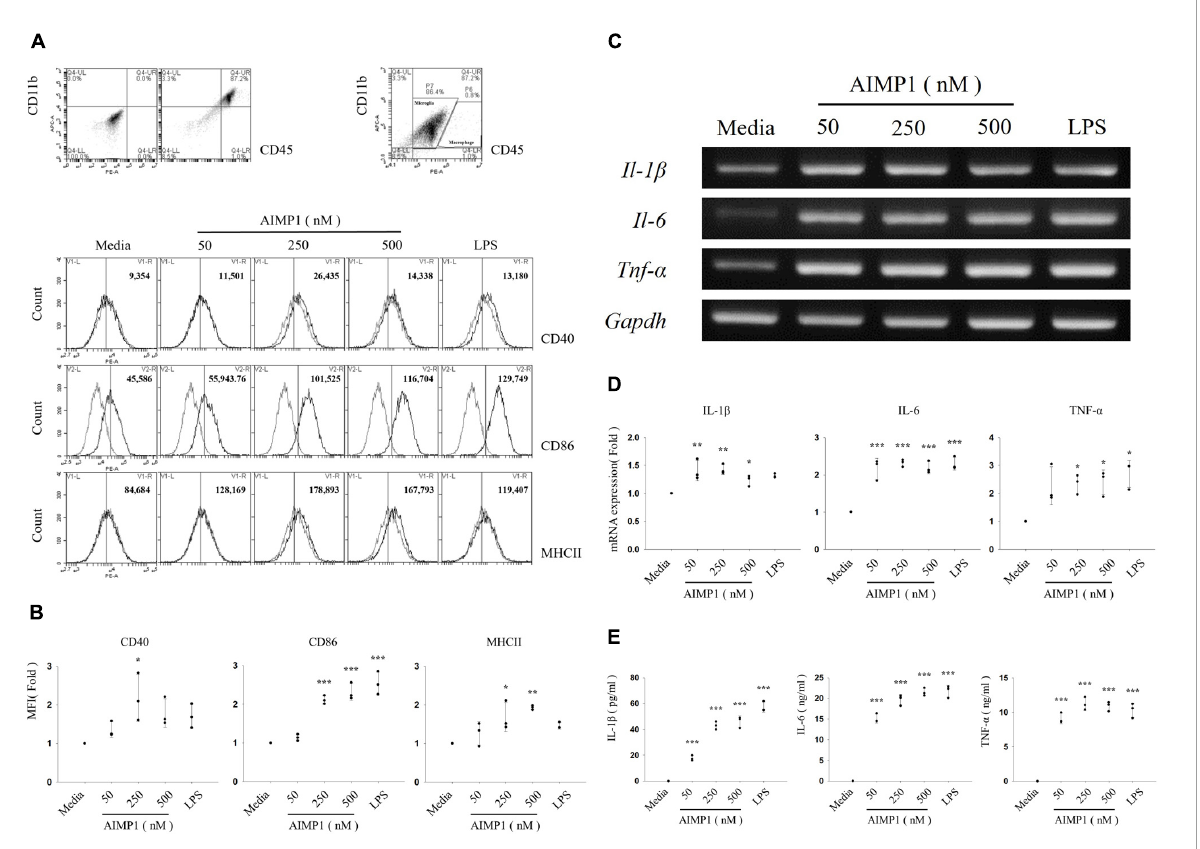
FIGURE1 Aminoacyl tRNA synthetase (ARS)-interacting multifunctional protein 1 (AIMP1) elevates the expression levels of surface markers and pro-inflammatory cytokines in the primary microglia Primary microglial cells were obtained from the cerebral cortex of C57BL/6 mice and cultured with AIMP1 (50, 250, and 500 nM) or lipopolysaccharides (LPSs) (100 ng/mL) for 24 (A,B,E) or 6 h (C,D) . (A) The values of histograms signify the mean fluorescence intensity (MFI) of CD40, CD86, and MHC II in CD11b + CD45 low gated microglia. (B) Scatter plots represent the fold ratio based on the MFI of each surface marker in the medium group. The data represent the mean ± standard deviation (SD) values of three independent experiments. (C) mRNA expression levels of interleukin (IL)-1 β , IL-6, and tumor necrosis factor (TNF)- α were quantified using reverse transcription-polymerase chain reaction (RT-PCR). Glyceraldehyde-3-phosphate dehydrogenase (GAPDH) served as a control. (D) Scatter plots represent the fold ratio of mRNA expression in each group compared with the medium group. The data represent the mean ± SD of three independent experiments. (E) Secretion of pro-inflammatory cytokines was analyzed using an enzyme-linked immunosorbent assay (ELISA). Scatter plots show the mean ± SD of three independent experiments performed in triplicate. Statistical significance was evaluated using one-way analysis of variance (ANOVA) with a Bonferroni post hoc test for multiple comparisons; * P < 0.05, ** P < 0.01, and *** P < 0.001 compared to the medium